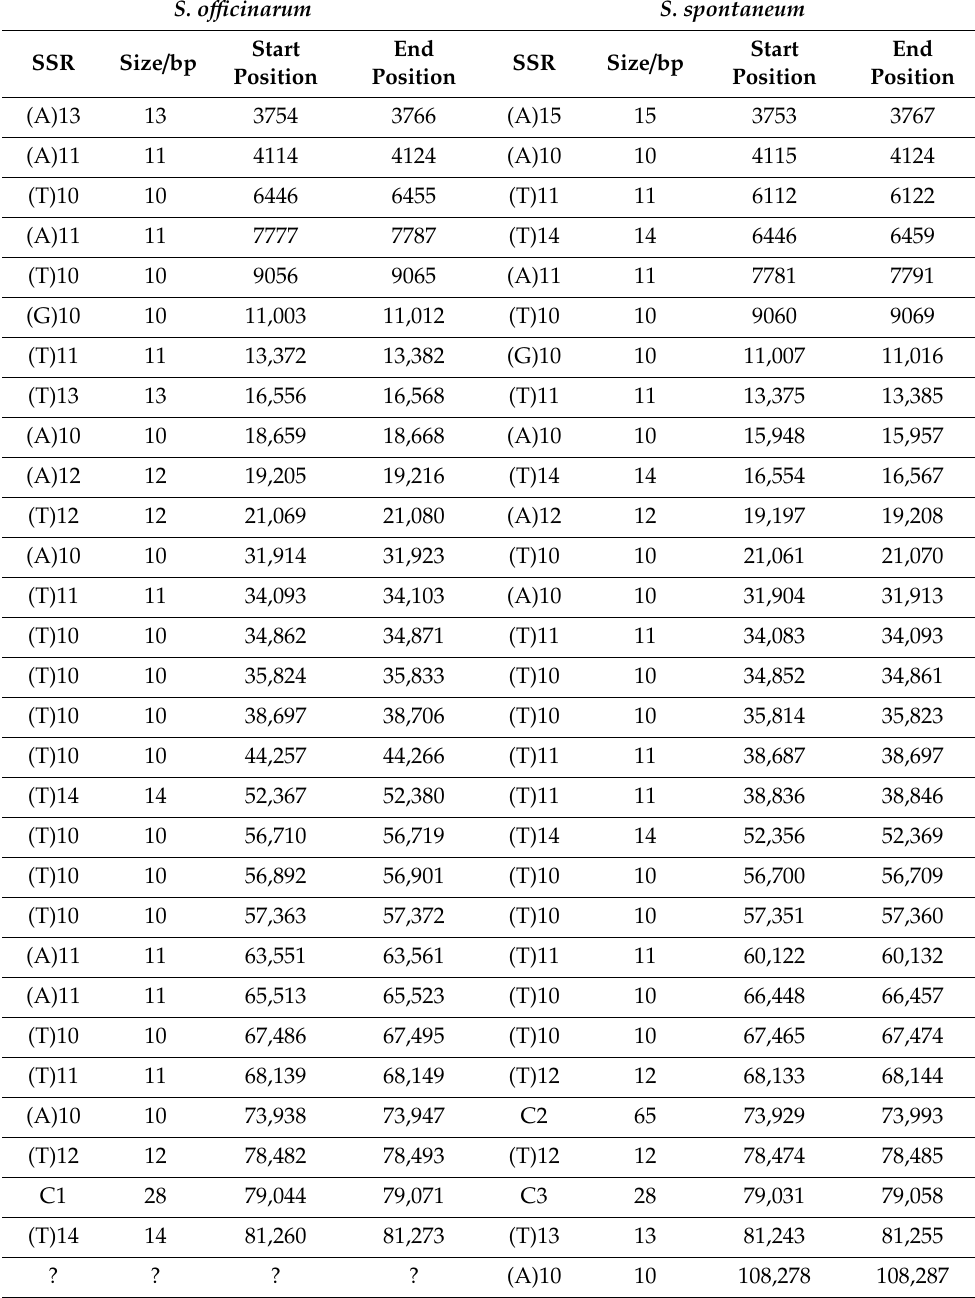
Table 4. SSRs identified in chloroplast genome sequences of Saccharum o ffi cinarum and S. spontaneum . S. o ffi cinarum S.